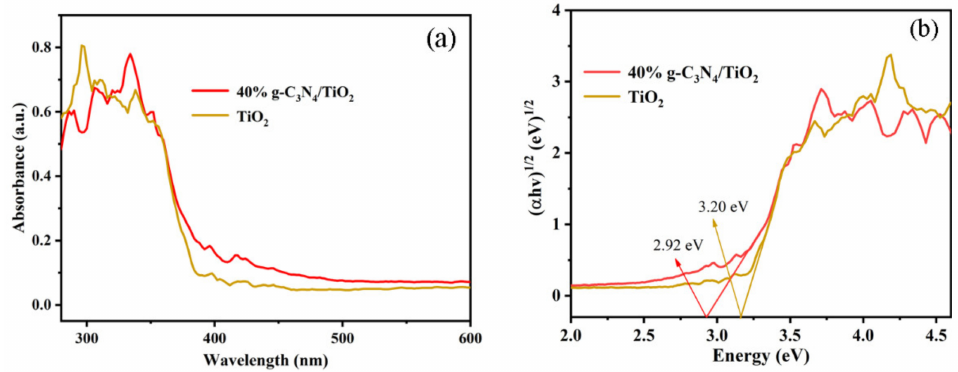
Figure 6. The UV-vis diffuse reflectance spectra ( a ) and band gaps ( b ) of TiO 2 and g-C 3 N 4 /TiO 2 composite.